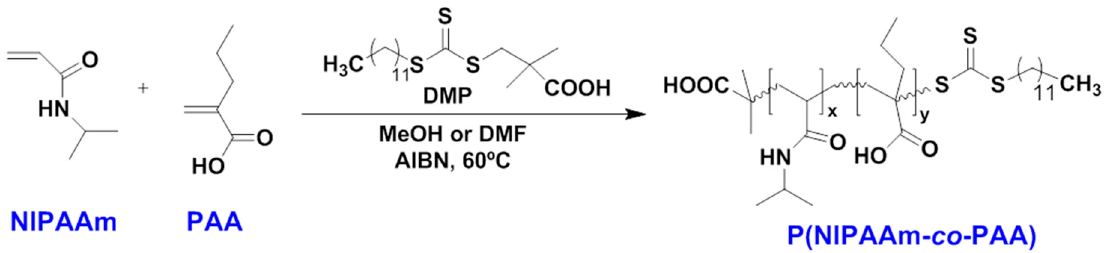
Figure 10. Scheme of P(NIPAAm- co -PAA) copolymer synthesis reported by Stayton and co-workers [98].